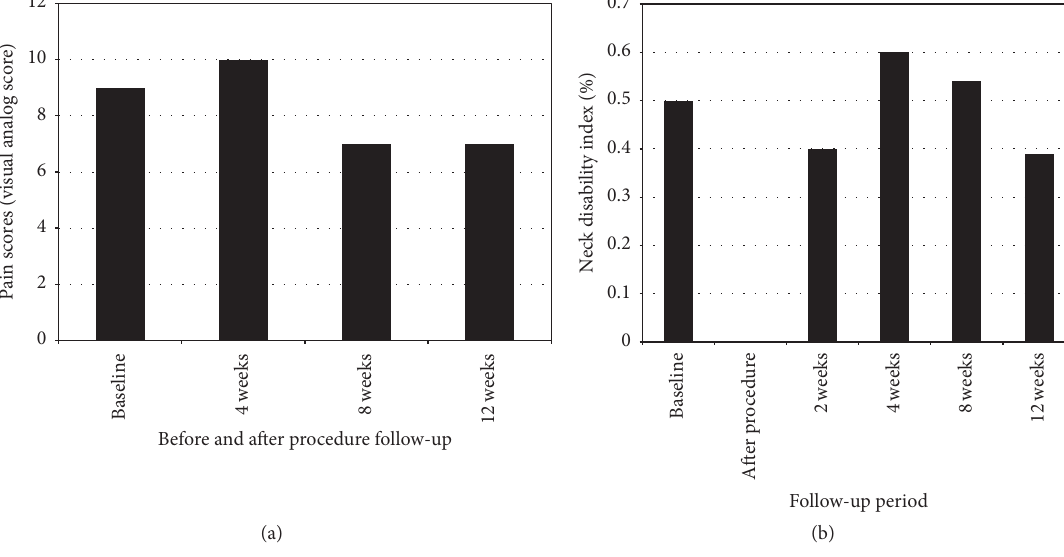
Figure 2: (a) Changes in visual analog pain score before procedure, and up to 12 weeks after procedure. (b) Changes in neck disability index, given as a percentage, before procedure and up to 12 weeks after procedure. A decrease of 10% from baseline score was used as an indicator of treatment